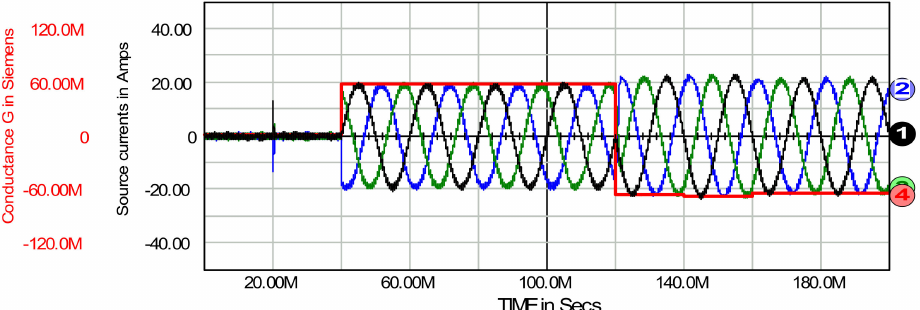
Figure 6. Source phase currents of phase A, B and C as waveforms 1, 2, and 3, respectively; and then the conductance signal (22): waveform